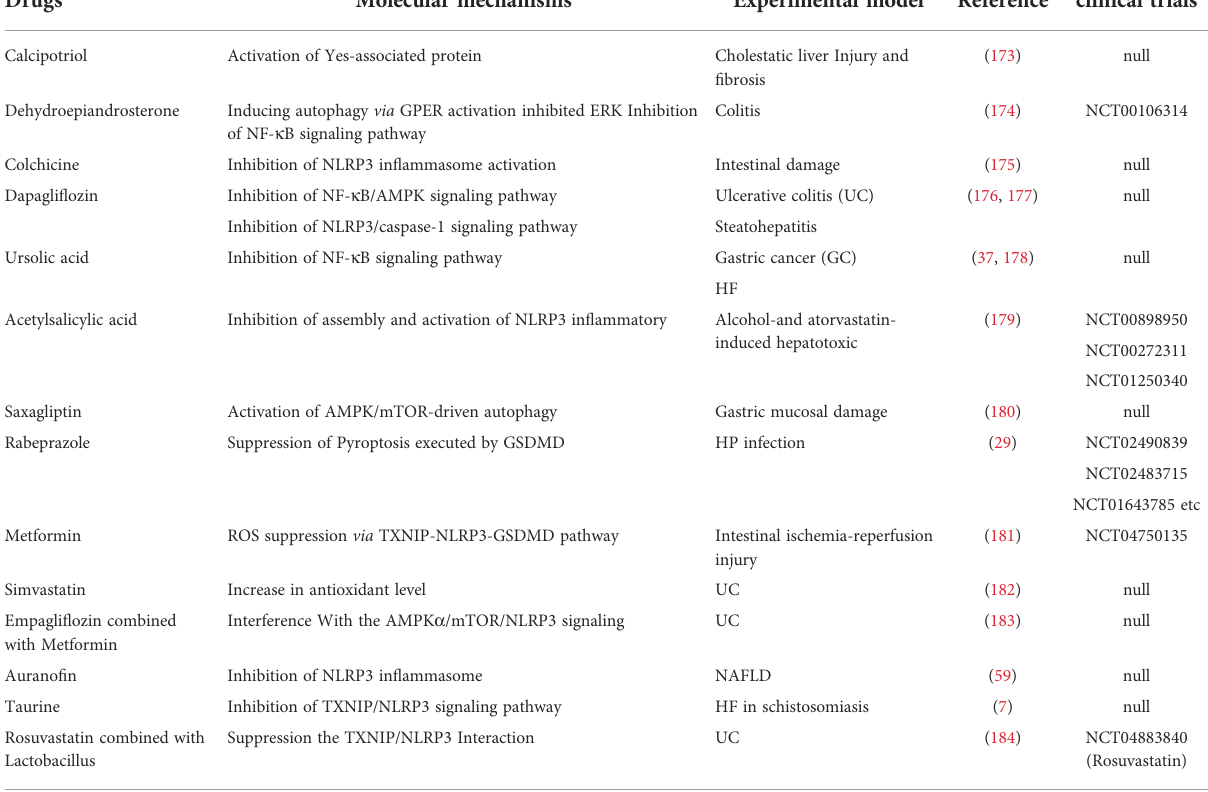
TABLE 2 Small ‐ molecule chemical drugs currently approved for clinical use and endowed with the ability to inhibit NLRP3 activation.